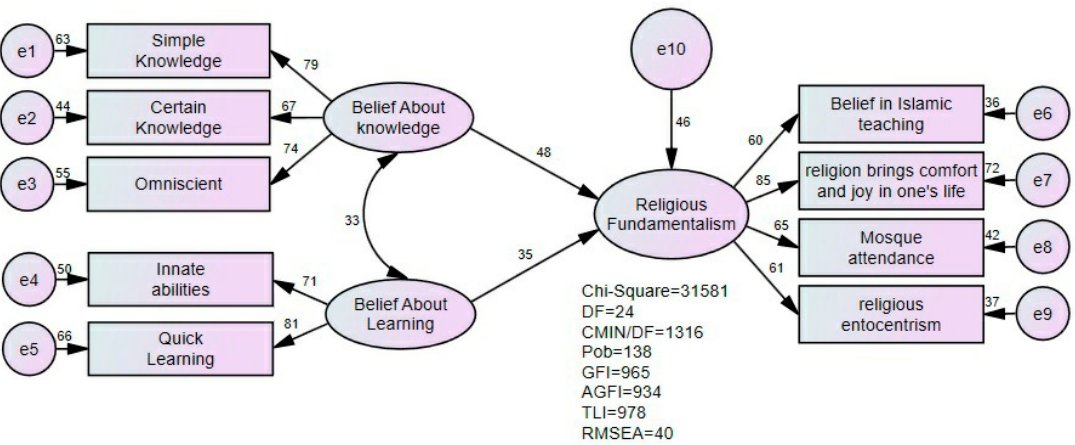
Figure 1. Full Figure 1. Full model.